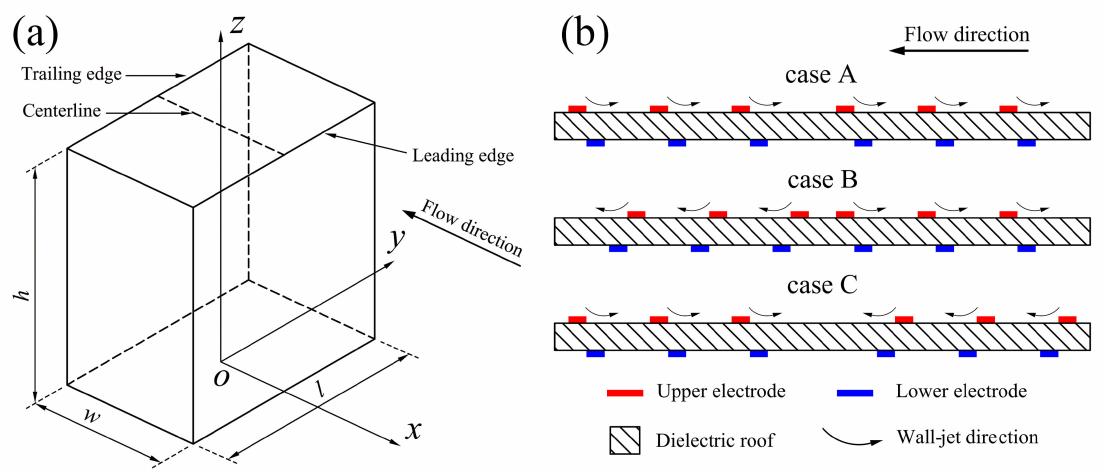
Figure 2. The building model and actuator configurations [19]: ( a ) reference model; ( b ) cross-sectional scheme of three actuator